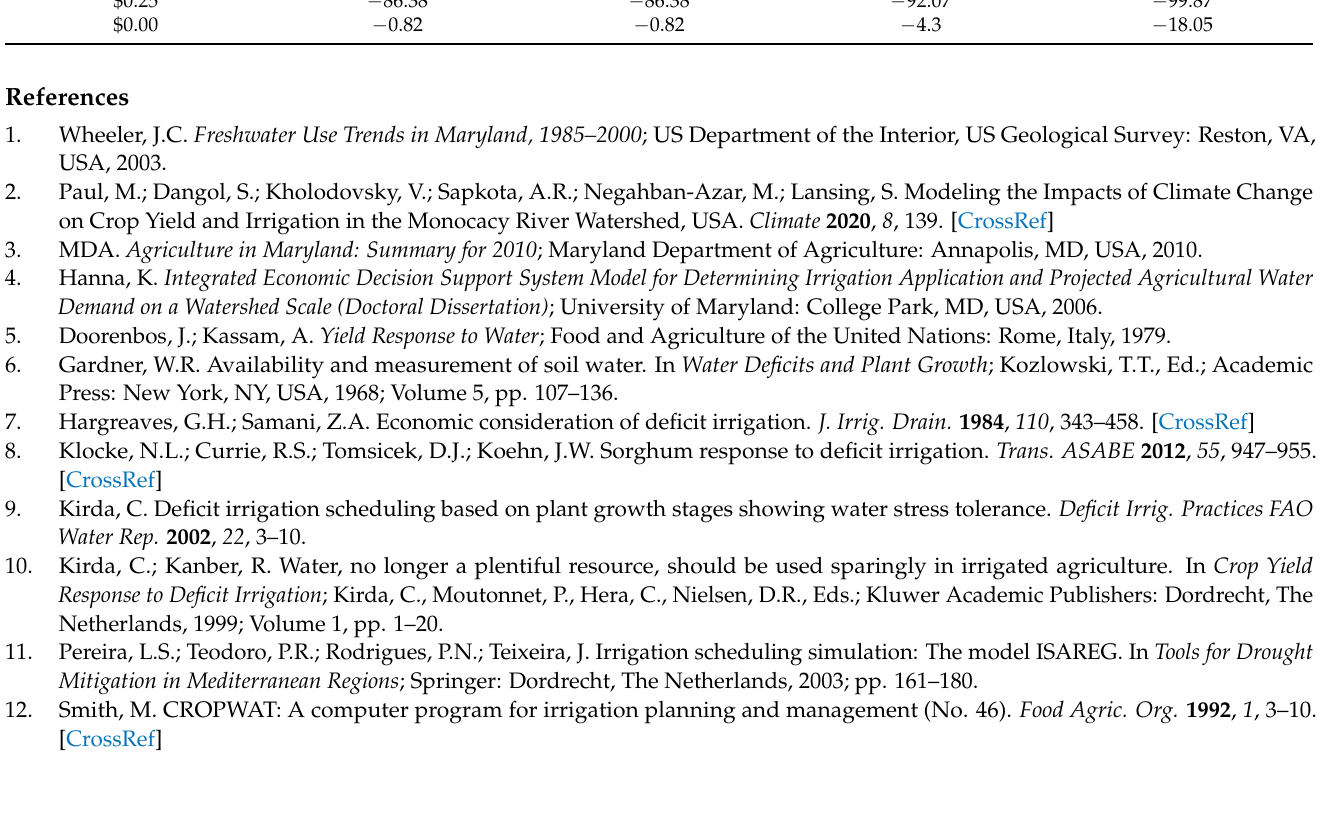
Net Benefit for Drip Irrigation System: [$/ha]